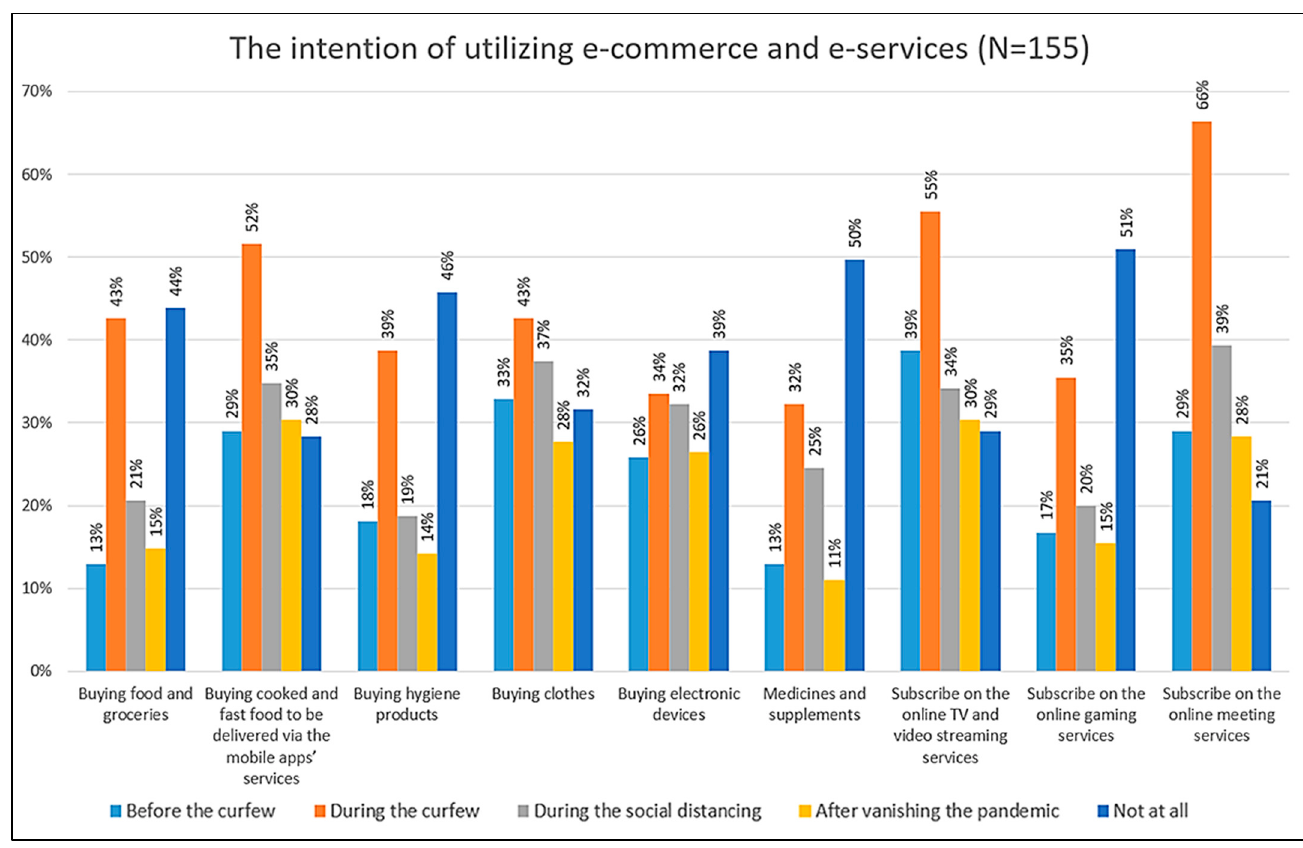
Figure 2. The intention of utilizing e-commerce and e-services ( n = 155).